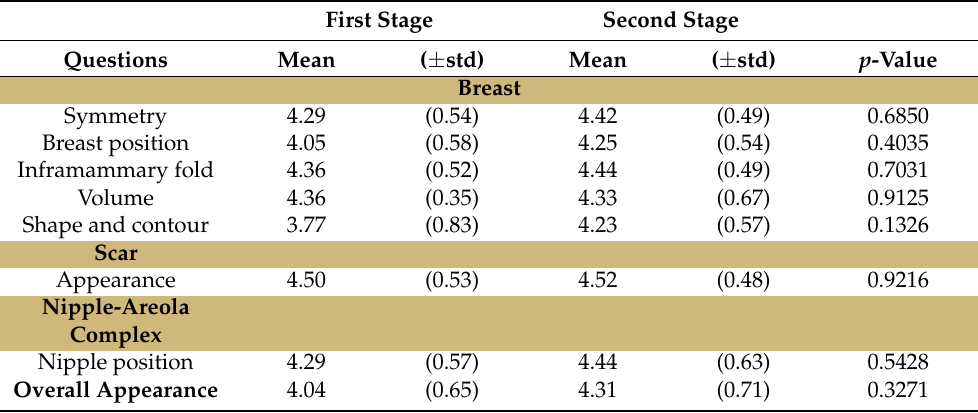
Table 8. Aesthetic evaluation of cosmetic results after the first and the second stage of